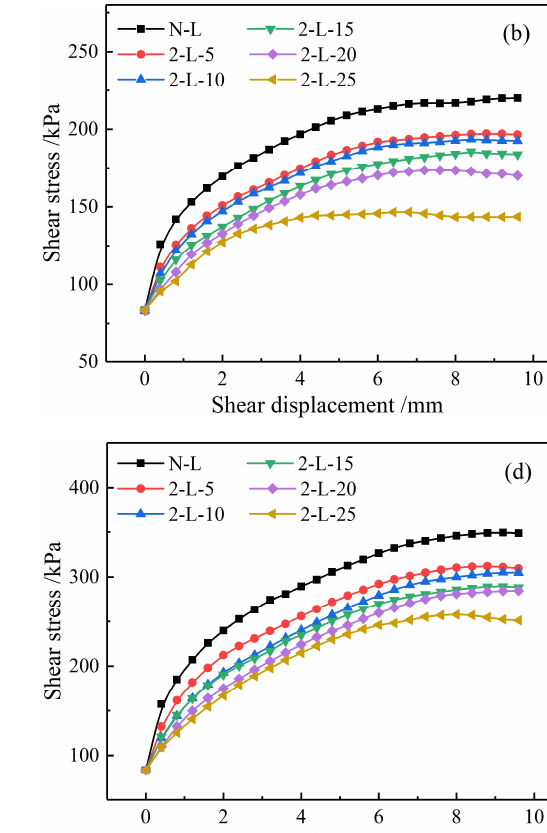
Table 3. The results of shear strength test.